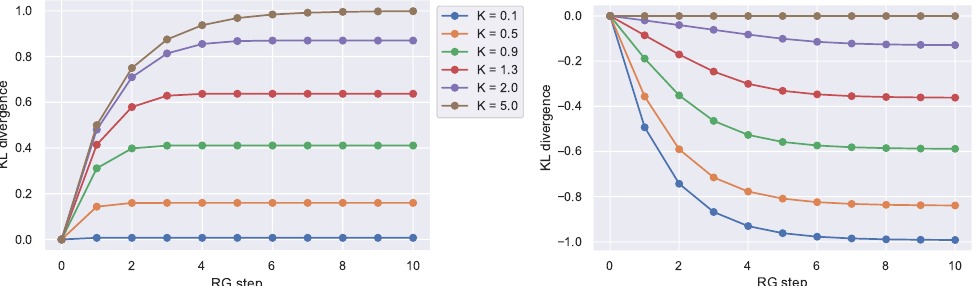
Figure 1: Relative entropy (Kullback-Leibler divergence) of the 1d classical Ising model as a function of real-space decimation step for various values of the nearest- neighbor coupling K . The left plot shows the correctly normalized entropy, while the right shows the same data without the normalization